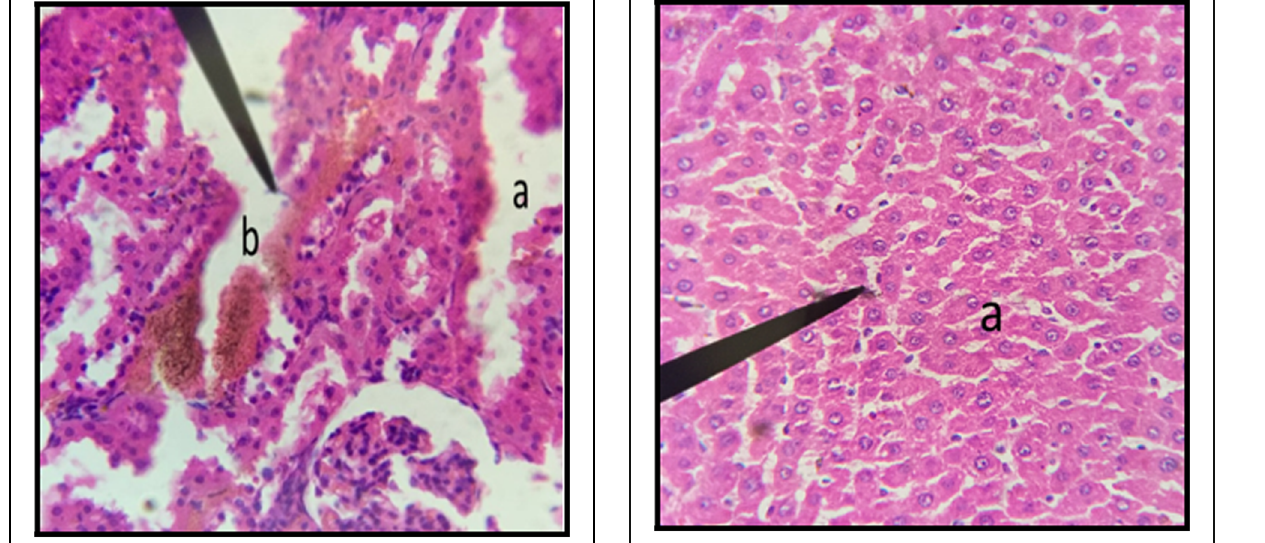
Fig. 10 Kidney Section of Female Rat (200 mg/kg/day) X400.